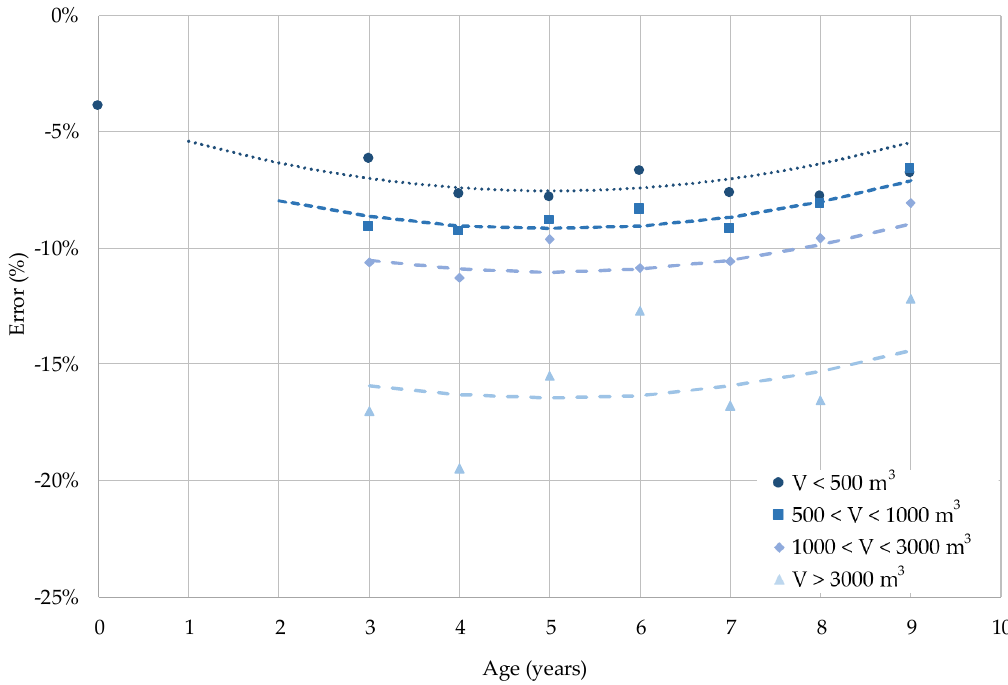
Figure 6. The degradation rate of the weighted error with age and totalised volume (meter M_2).